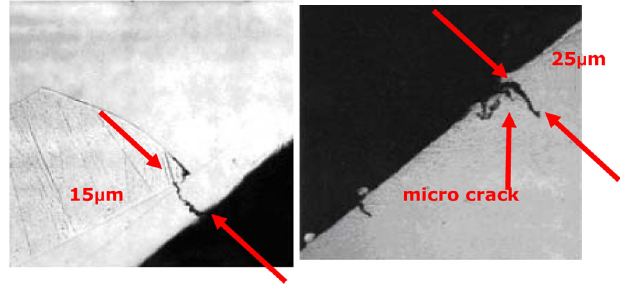
FIG. 1. Transgranular view of cracks in the material of the accelerating structures (reproduced from Ref.